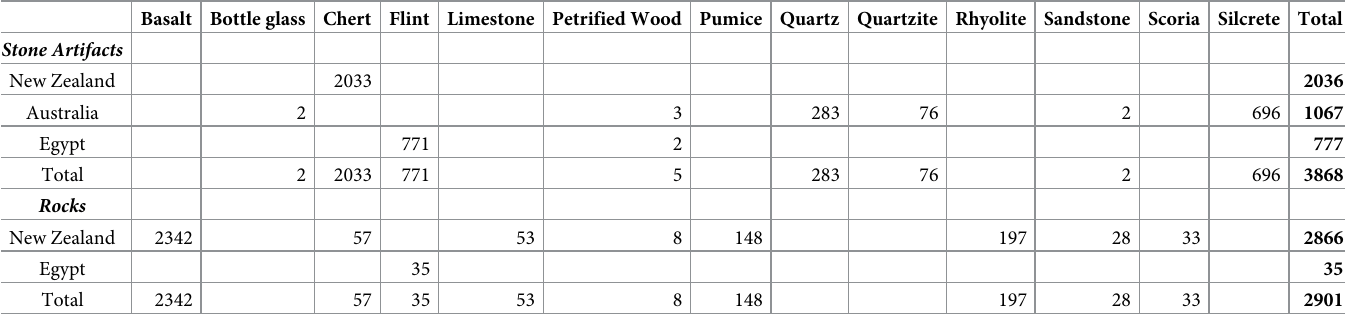
Table 1. Frequency of the stone artifact and rock raw material types used to train the machine learning data model, by case study